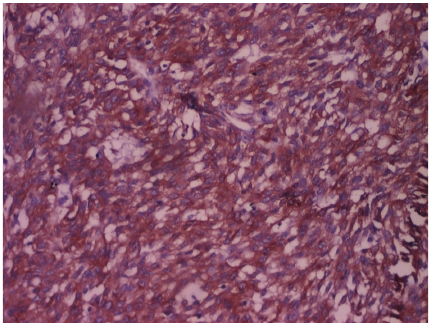
Figure 6: Spindle cells showing strong immunoreactivity for CD117 on IHC (score 3+ to 4+) (100x